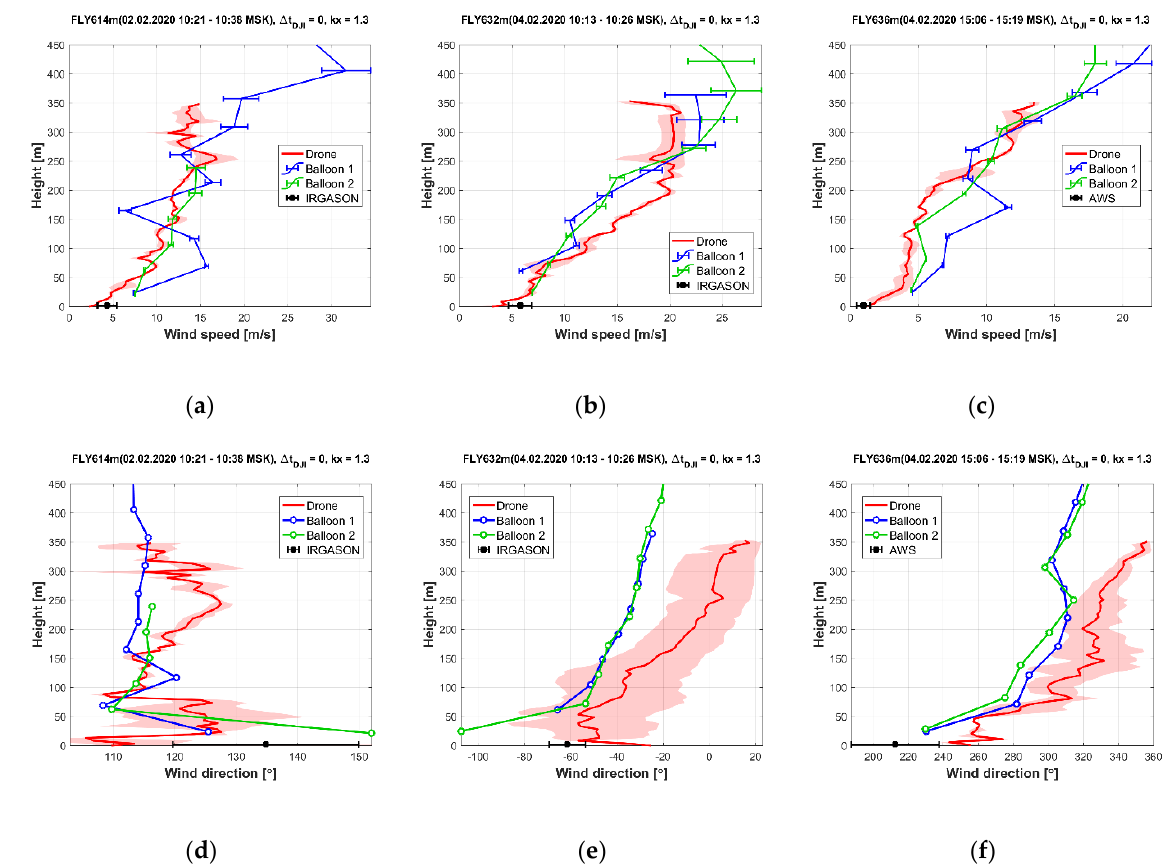
Figure 7. Examples of comparison between balloon and drone sounding for wind speed ( a – c ) and direction ( d – f ) profiles for three cases, when balloon sounding was performed twice. Designations are similar to Figure 5.